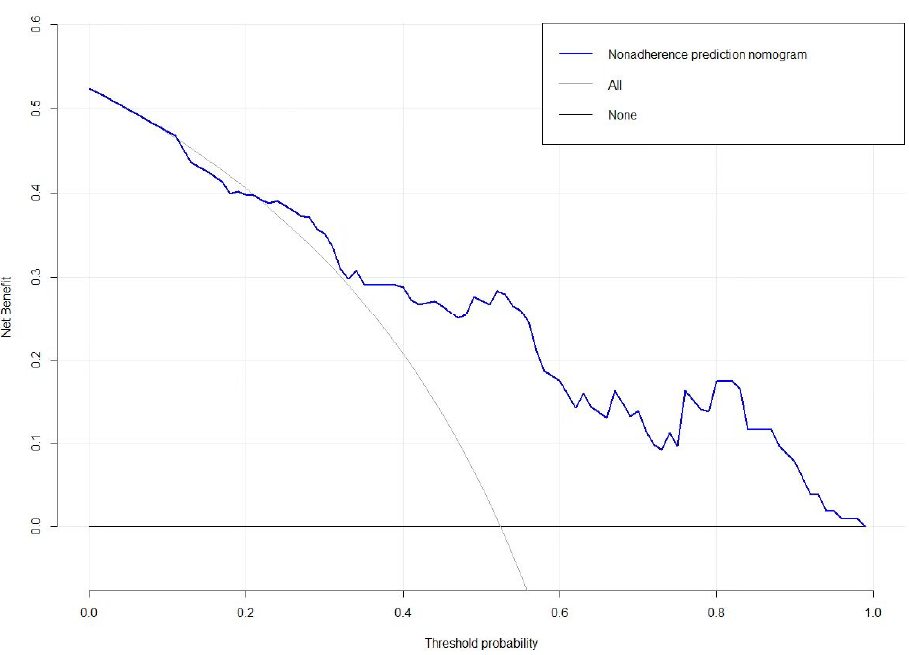
Figure A5. The decision curve analysis diagram of the model.